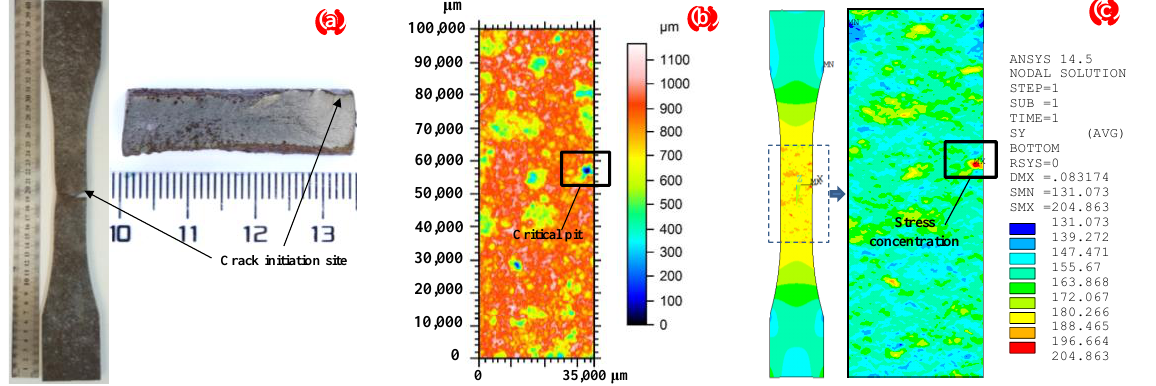
Figure 11. Comparison of ( a ) fatigue test, ( b ) 3D morphology scanning, and ( c ) FEM results of specimen C6-U-S1.